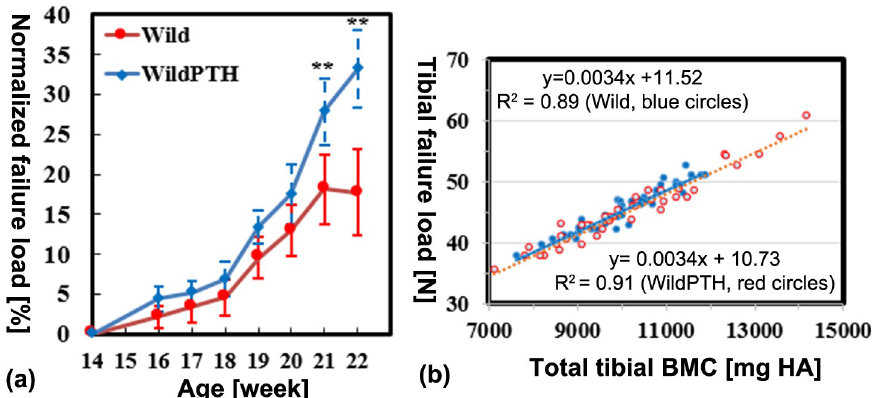
Fig 5. (a) Longitudinal effects of PTH intervention on the FE predicted tibial failure load. The data are presented as the mean standard deviation of the normalized data with respect to baseline ( � p < 0.05, �� p < 0.01). (b) Linear regression analysis for the relationships between the FE predicted failure loads and tibial BMCs (Wild group in blue circles and WildPTH group in red